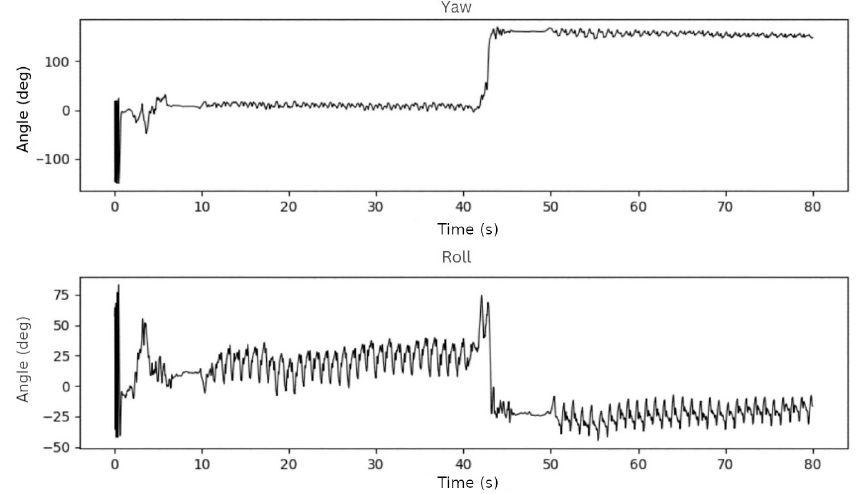
Figure 3. Yaw and roll angles on the first test.